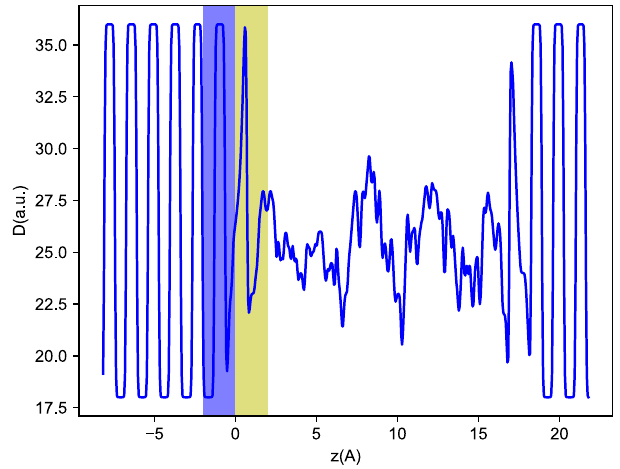
Fig. 10 Density matching at the left interface. The z-dependent density of a stack averaged within a 2.5 Å thick sliding cuboid, centered at z and integrated over the lateral r = ( x , y ) coordinate across the entire lateral extent of the stack. The shaded regions show the 2.5 Å cuboid representing (blue) the top of c-Si, and (yellow) the bottom of the a-Si:H. The peak height in both regions shows the smooth transition of the Si density across the interface, similar to the desired structure of the transition zone passivating layer.